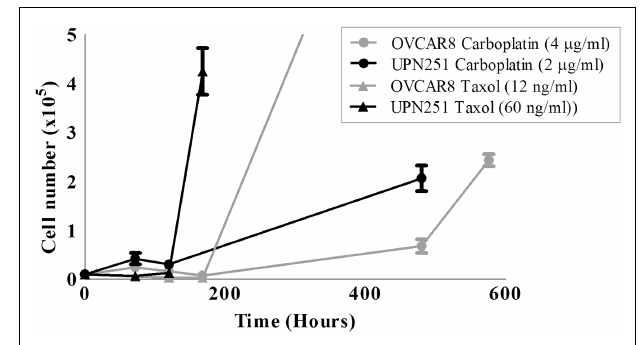
FIGURE 1 | Recovery of OVCAR8 and UPN251 from carboplatin or paclitaxel treatment . 1 × 10 4 cells were treated for 3days with the indicated doses of either carboplatin or paclitaxel and recovery monitored as described in Section